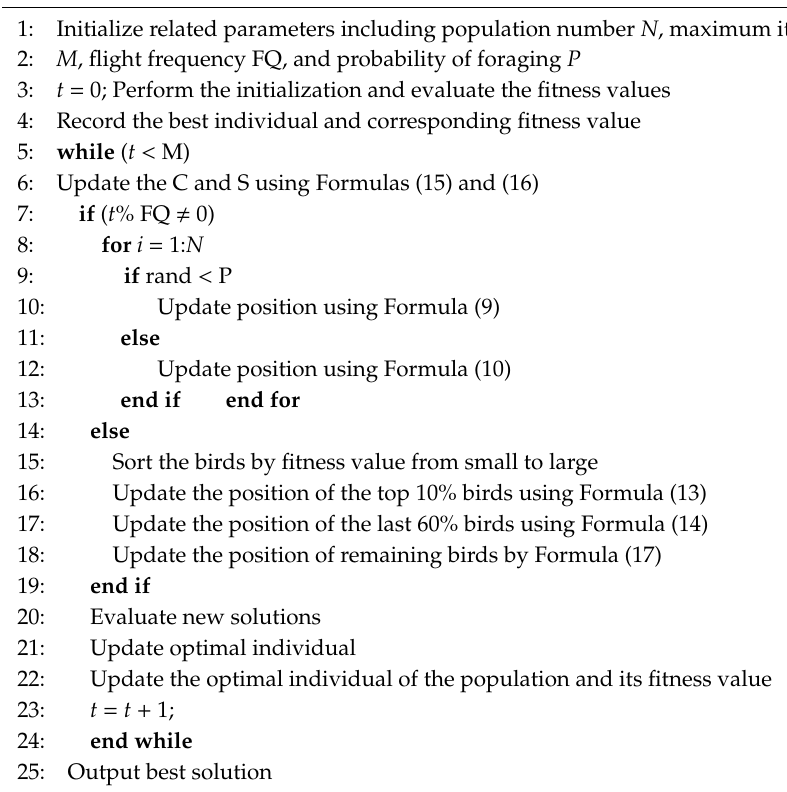
Algorithm 1 Improved Bird Swarm Algorithm